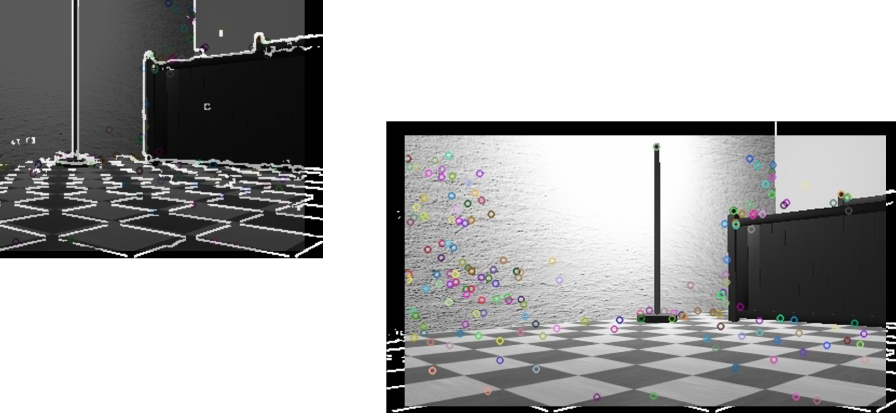
Figure 14. Figure showing features detected in frame.